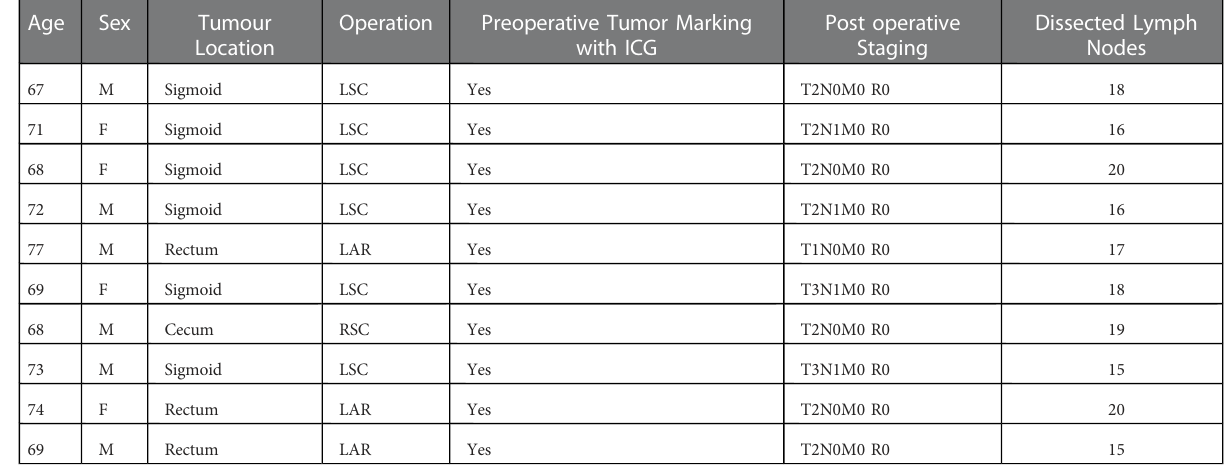
TABLE 5 Summary of